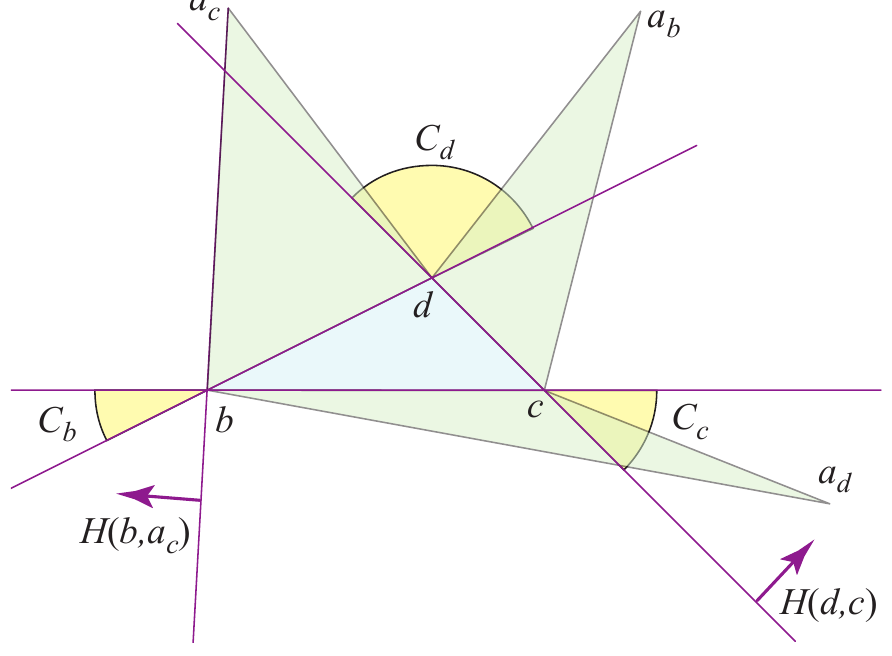
Figure 10. Case 1. a d cannot be in both C c and H ( b , a c ) . Case 2: Two a -images in two different